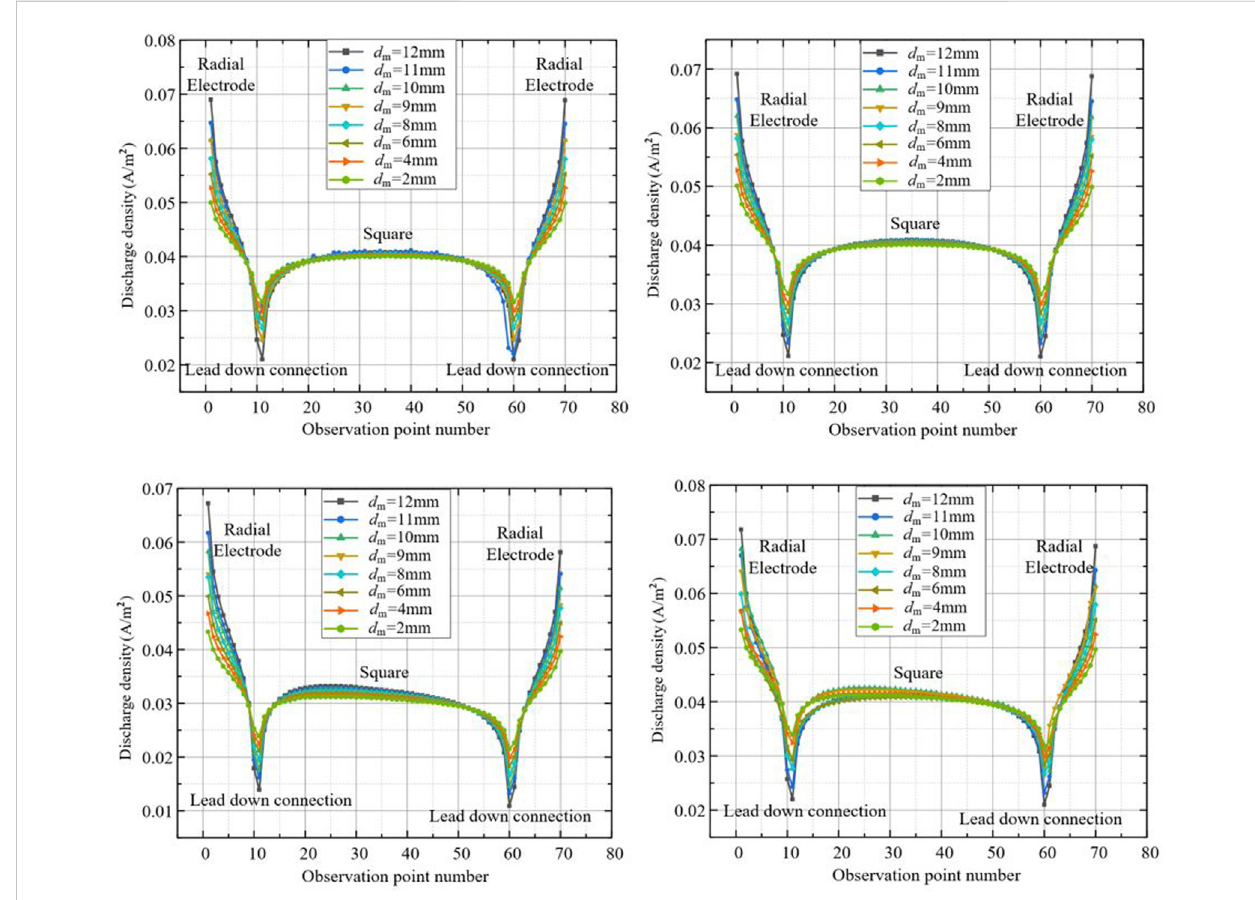
FIGURE 5 Impulse dischargecharacteristics ofcorroded grounding electrodes atdifferentfrequencypoints: (A) 2500 Hz; (B) 10 kHz; (C) 50 kHz; (D) 100 kHz.